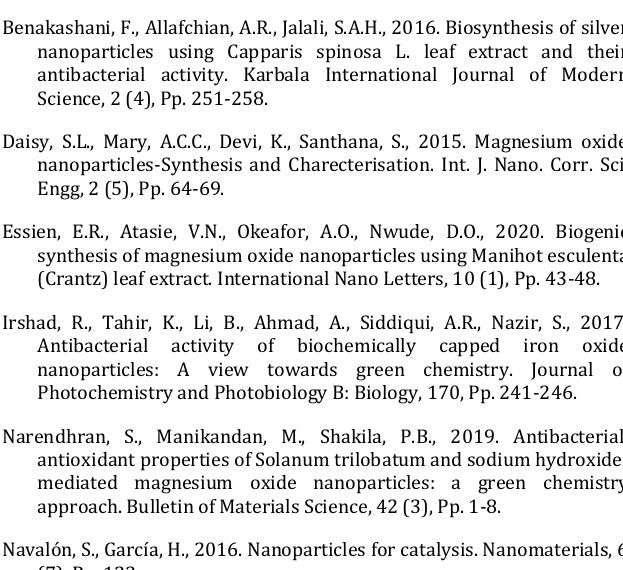
Figure 3: (a-c) EDS profile of green synthesized MgO